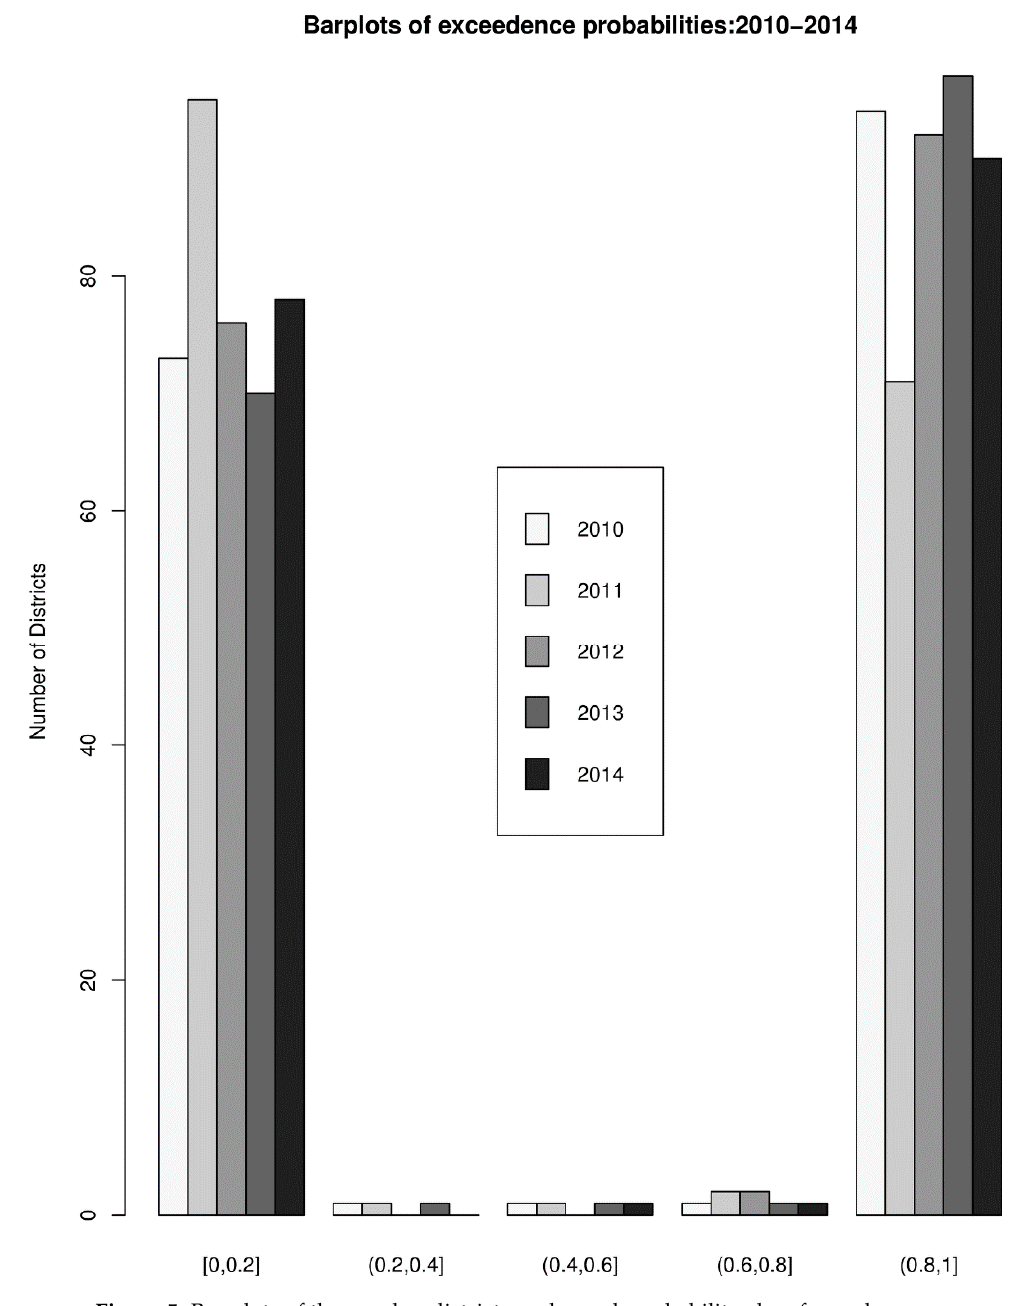
Figure 5. Bar plots of the number districts under each probability class for each year.